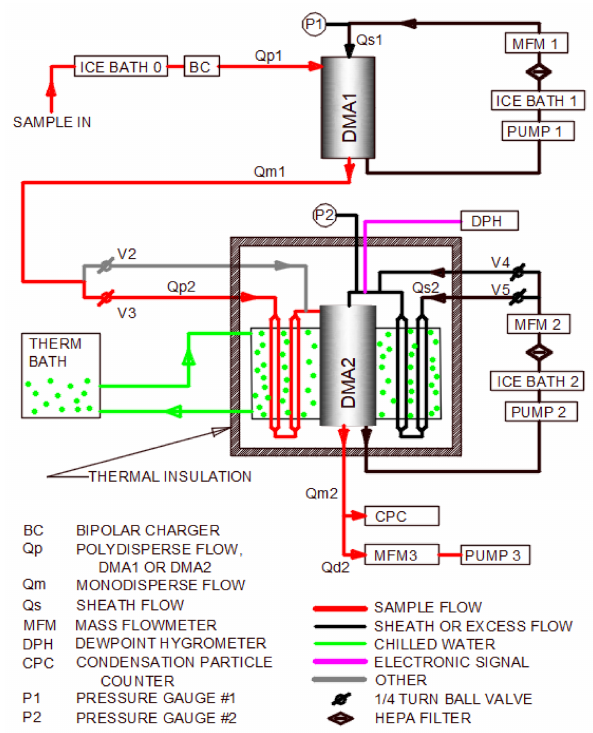
Figure 1. Schematic of the MST HTDMA